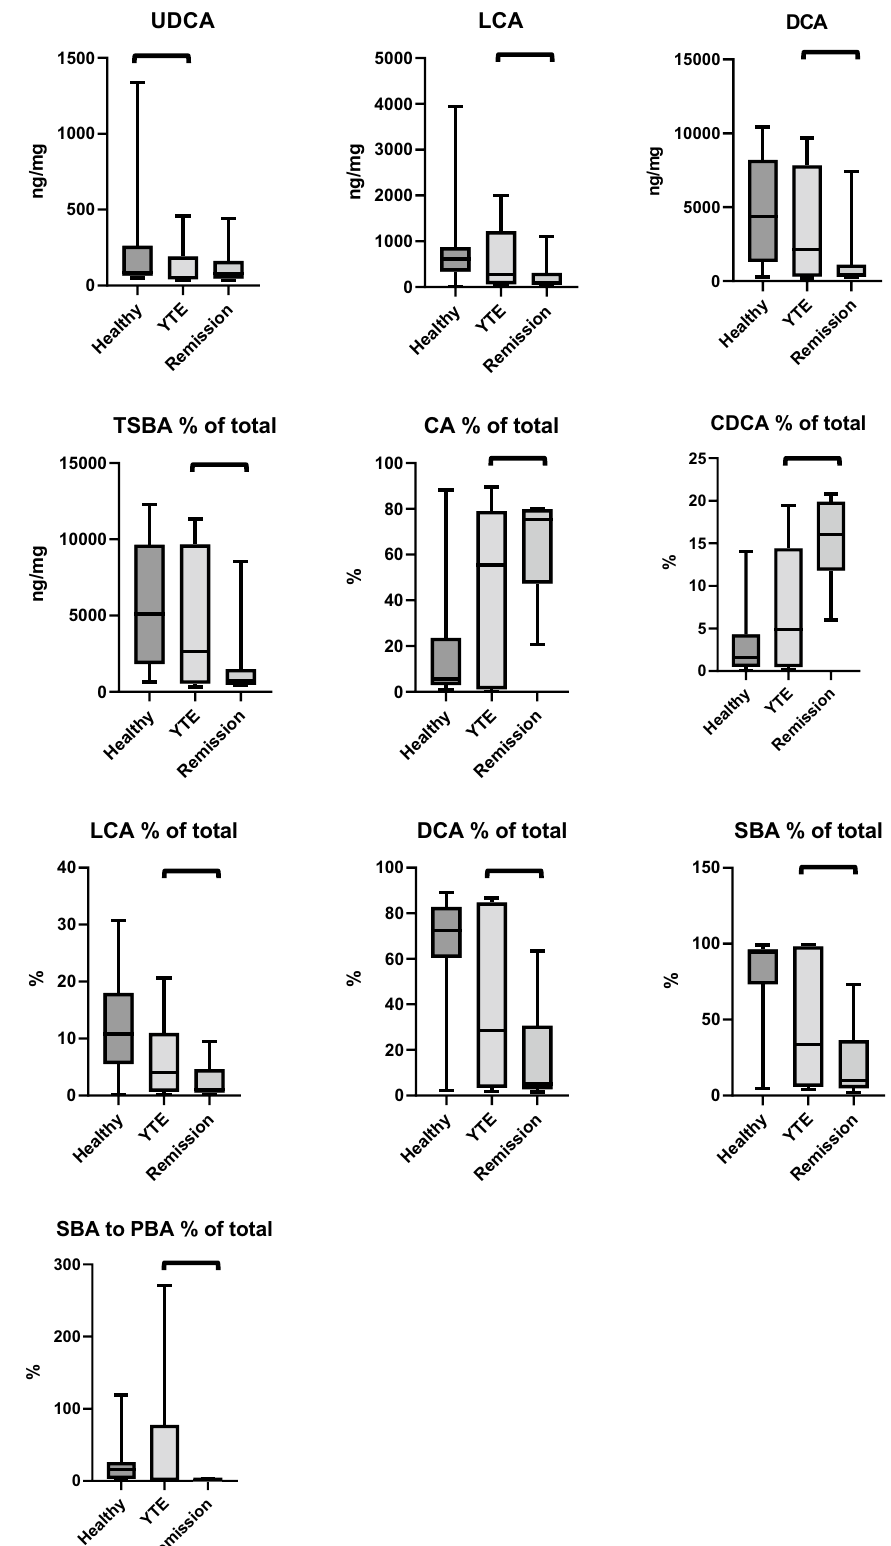
Figure 2. Box plots comparing total amounts and percentages of fecal bile acid concentrations and the ratio of secondary to primary fecal bile acids in healthy controls, dogs with YTE, and dogs with YTE after achieving clinical remission. Square brackets are indicating significant differences between groups. Box plots represent the 25–75th percentile; the median is shown as the heavy dark horizontal line. Vertical lines extend to the minimum and maximum values. UDCA, ursodeoxycholic acid; LCA, lithocholic acid; CDA, chenodeoxycholic acid; DCA, deoxycholic acid; TSBA, total secondary bile acids; CA, cholic acid; CDCA, chenodeoxycholic acid; SBA, secondary bile acids; SBA to PBA, ratio of primary to secondary bile acids; YTE, Yorkshire Terrier